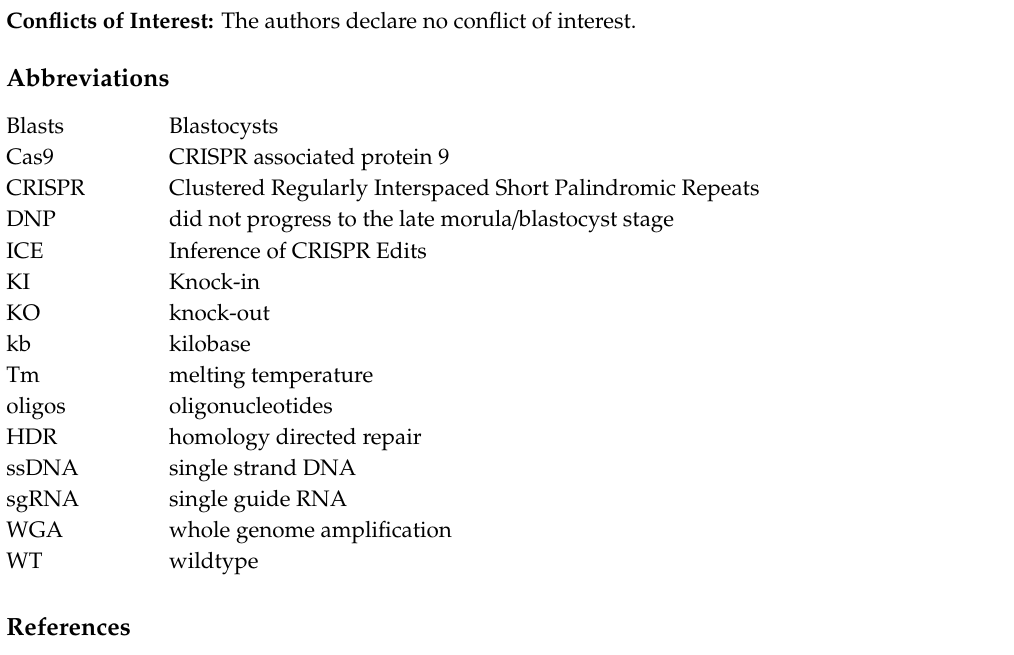
Figure S1: Pattern of guide RNA cutting compared to pattern of donor DNA integration for di ff erent guide / donor pairs in Magi1., Figure S2: Di ff erent patterns of cutting, similar pattern of integration from di ff erent guide / donor pairs in di ff erent genes, Table S1: Sequence of single guide RNA and donor DNA pairs, Table S2: CRISPR component concentrations for each experimental condition, Table S3: Nested PCR primers used for sequencing, Table S4: Estimation of guide RNA directed cutting e ffi